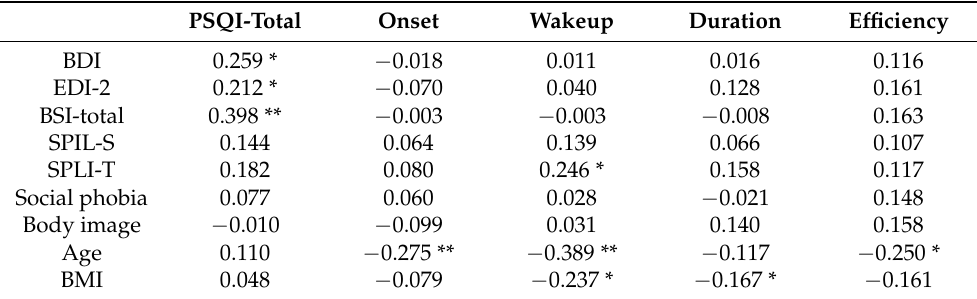
Table 3. Pearson correlation coefficients between ED-related psychopathology and objective and subjective sleep quality (Spearman correlations with efficiency). PSQI-Total Onset Wakeup Duration Efficiency BDI